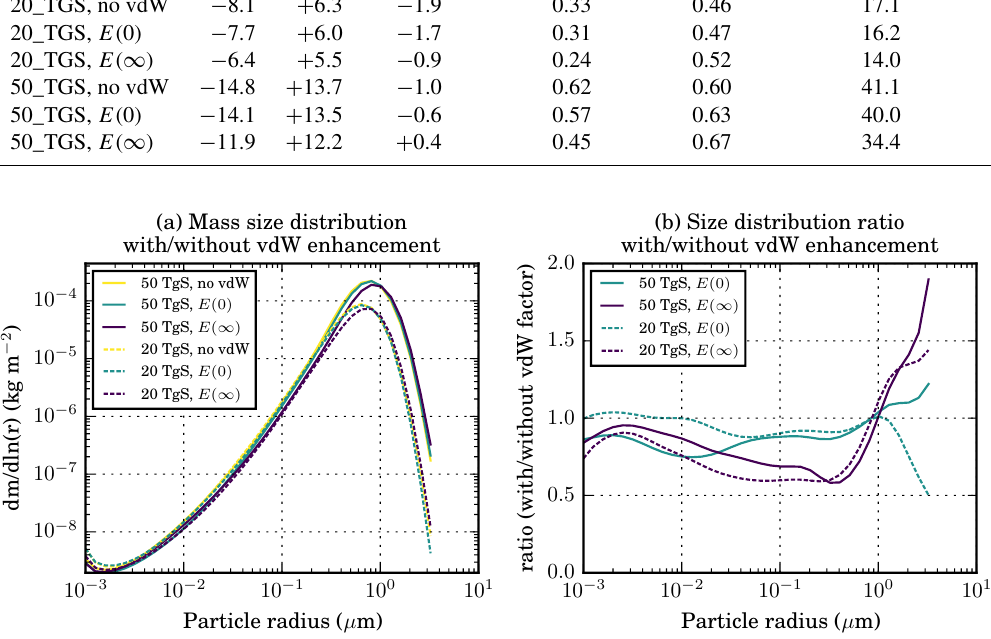
Table 3. Global mean quantities for experiments with and without van der Waals (vdW) enhancement of coagulation at injection rates of 20 and 50TgSyr − 1 , respectively. The enhancement factor E( ∞ ) for the kinetic regime is generally larger than the factor E( 0 ) for the continuum regime. Uniformly enhancing coagulation by E( ∞ ) can therefore be seen as an upper limit of the impact of vdW forces. Experiment Radiative forcing (Wm − 2 ) AOD at 550nm r eff (µm) Aerosol burden (TgS) SW LW